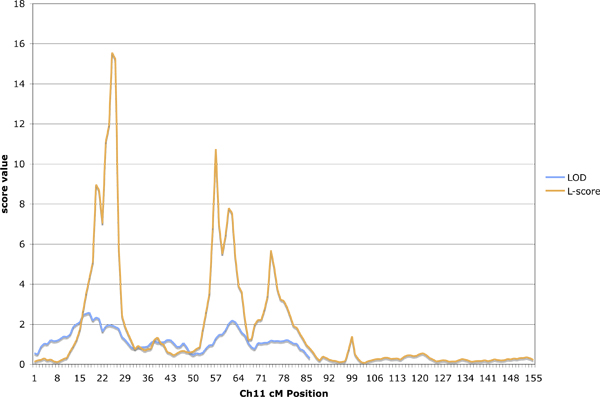
Agreement between methods within replicate. Comparison of linkage results for simulated LDL at Visit 1, adjusted for age and sex, for L-scores from oligogenic simultaneous segregation and linkage analysis (without association testing) and for LOD from variance-components methods. Vertical scales are not comparable, but note agreement of peak locations